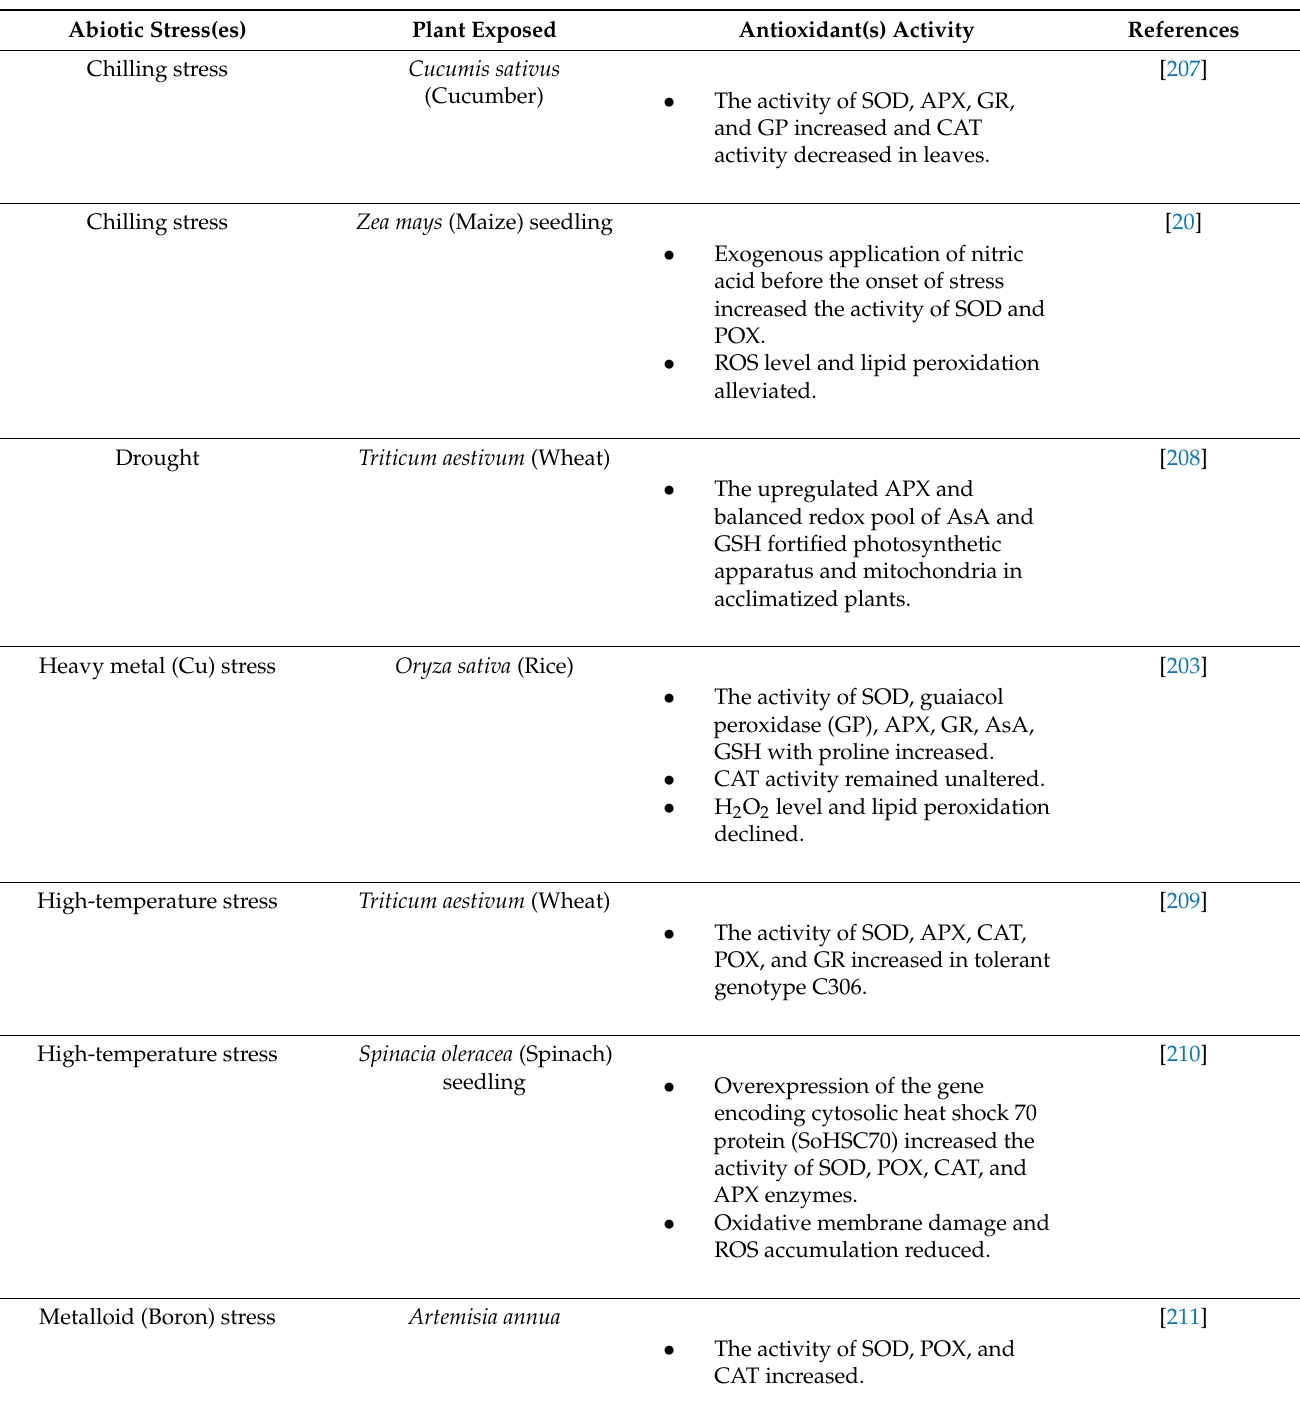
Table 2. Antioxidant activity in plants in response to abiotic stress-induced oxidative